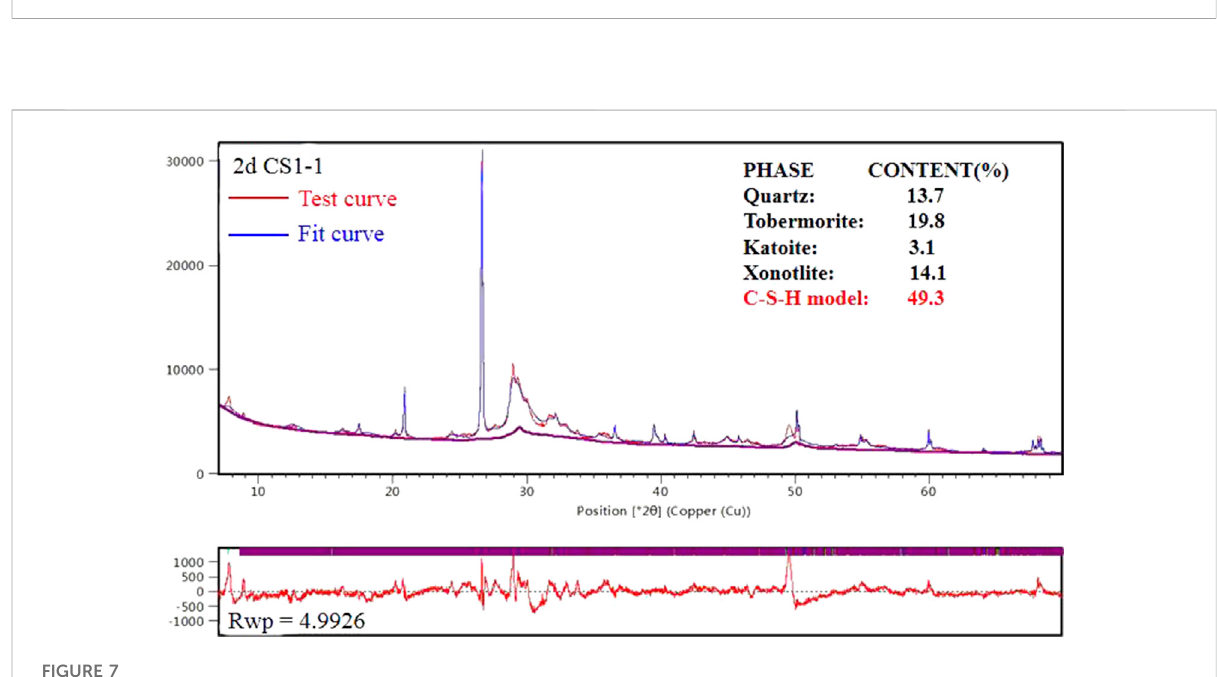
FIGURE 7 Application of calcium – silicate – hydrates model in representative